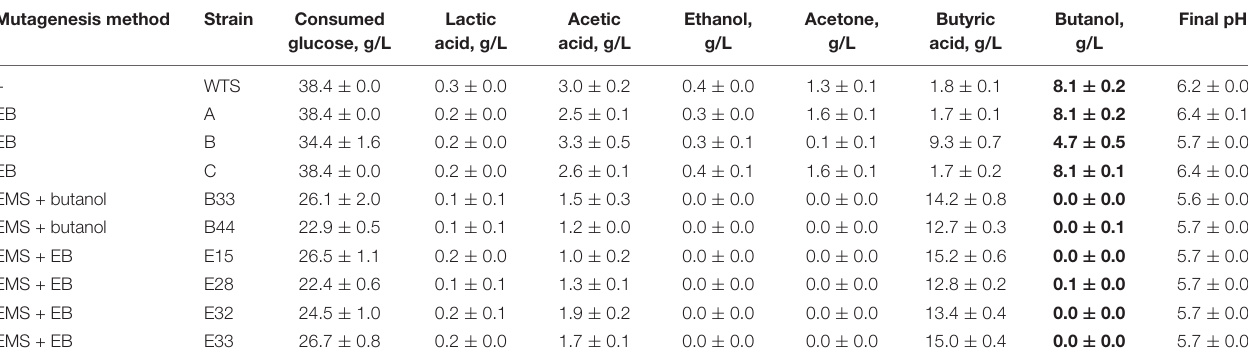
TABLE 2 | Concentrations of glucose, acids and solvents and pH reached by C. beijerinckii NRRL B-598 (WTS) and its mutant strains in TYA medium containing 10 g/L of CaCO 3 after 72 h cultivation 1